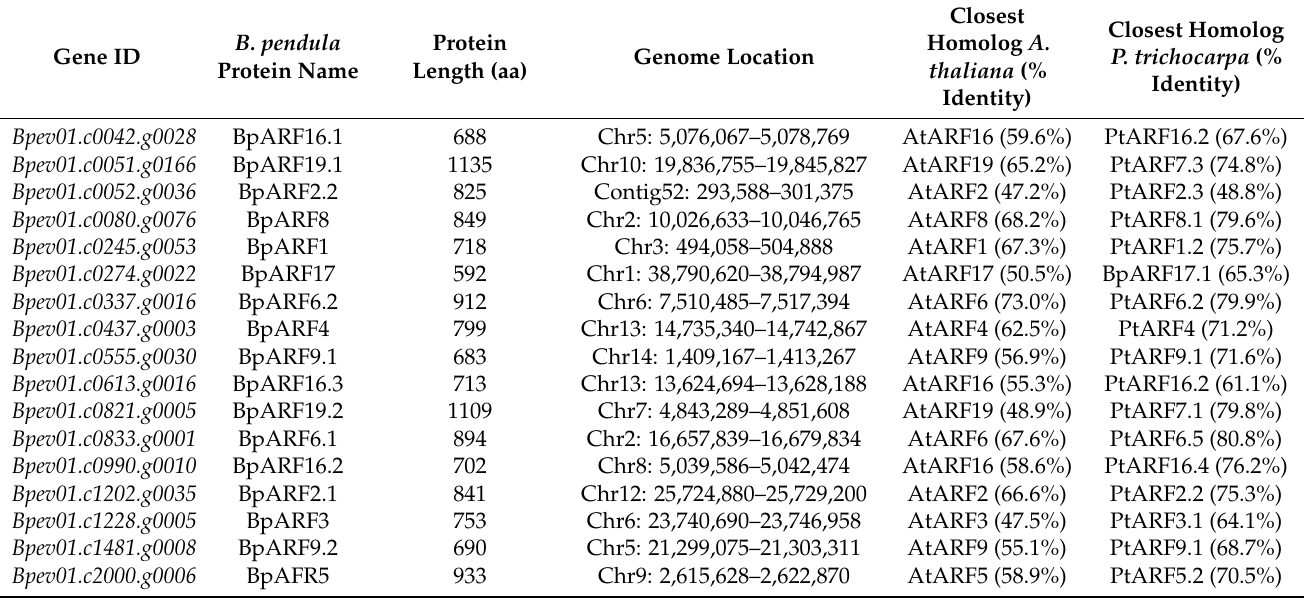
Table 2. Characteristics of ARF members in